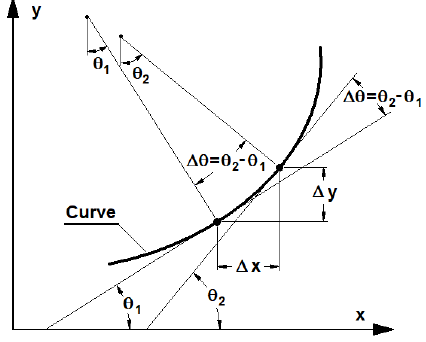
Figure 2. The geometrical elements of the curve.